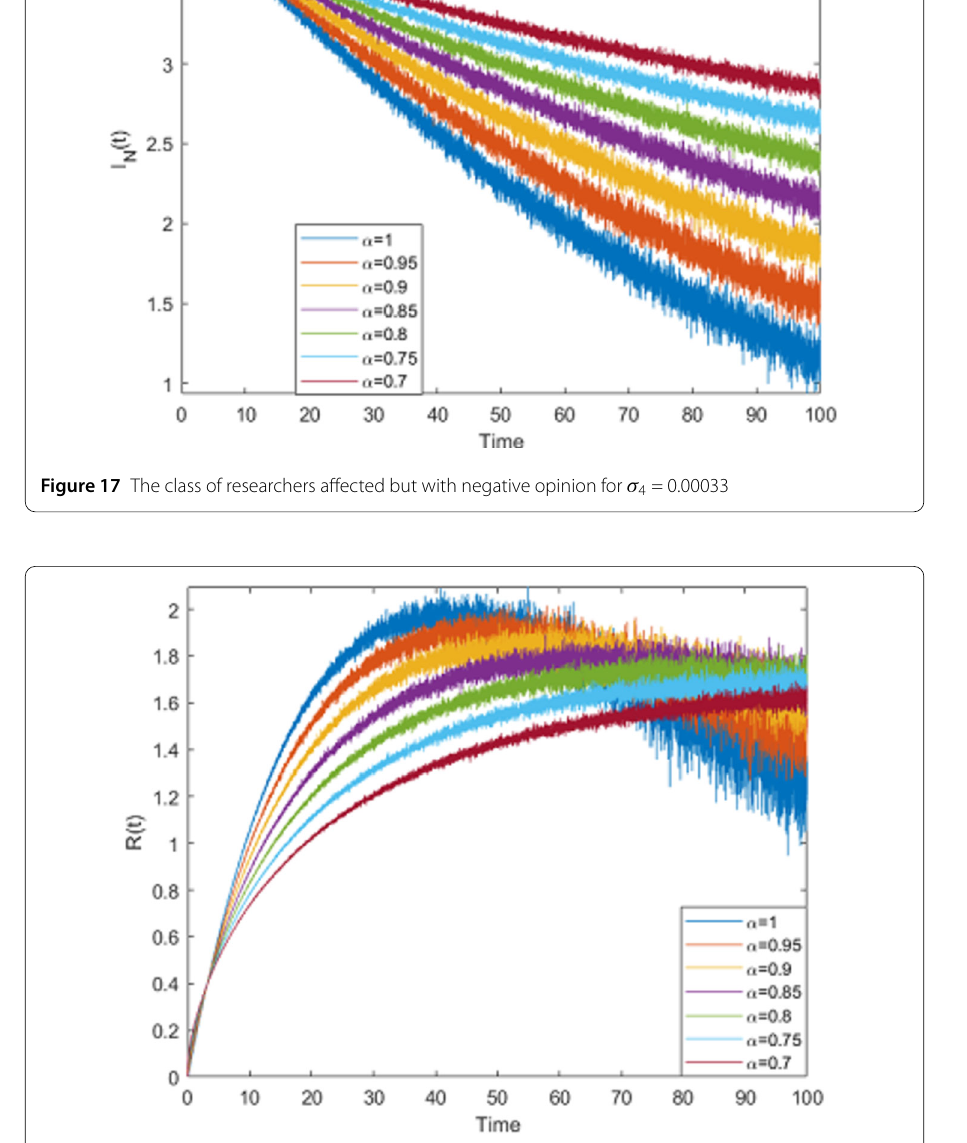
fectious disease, was herein introduced. This analysis included the strength number that is obtained by taking the second derivative of a nonlinear part of infectious classes and then applying similar routine to obtain the reproductive number. The utilization of sec- ond derivative of the Lyapunov function was introduced to find the sign of the second derivative of each class, with the aim to detect waves. The mathematical model was fur- ther converted to a stochastic one and solved numerically using the numerical scheme based on the Newton polynomial interpolation. The results obtained from